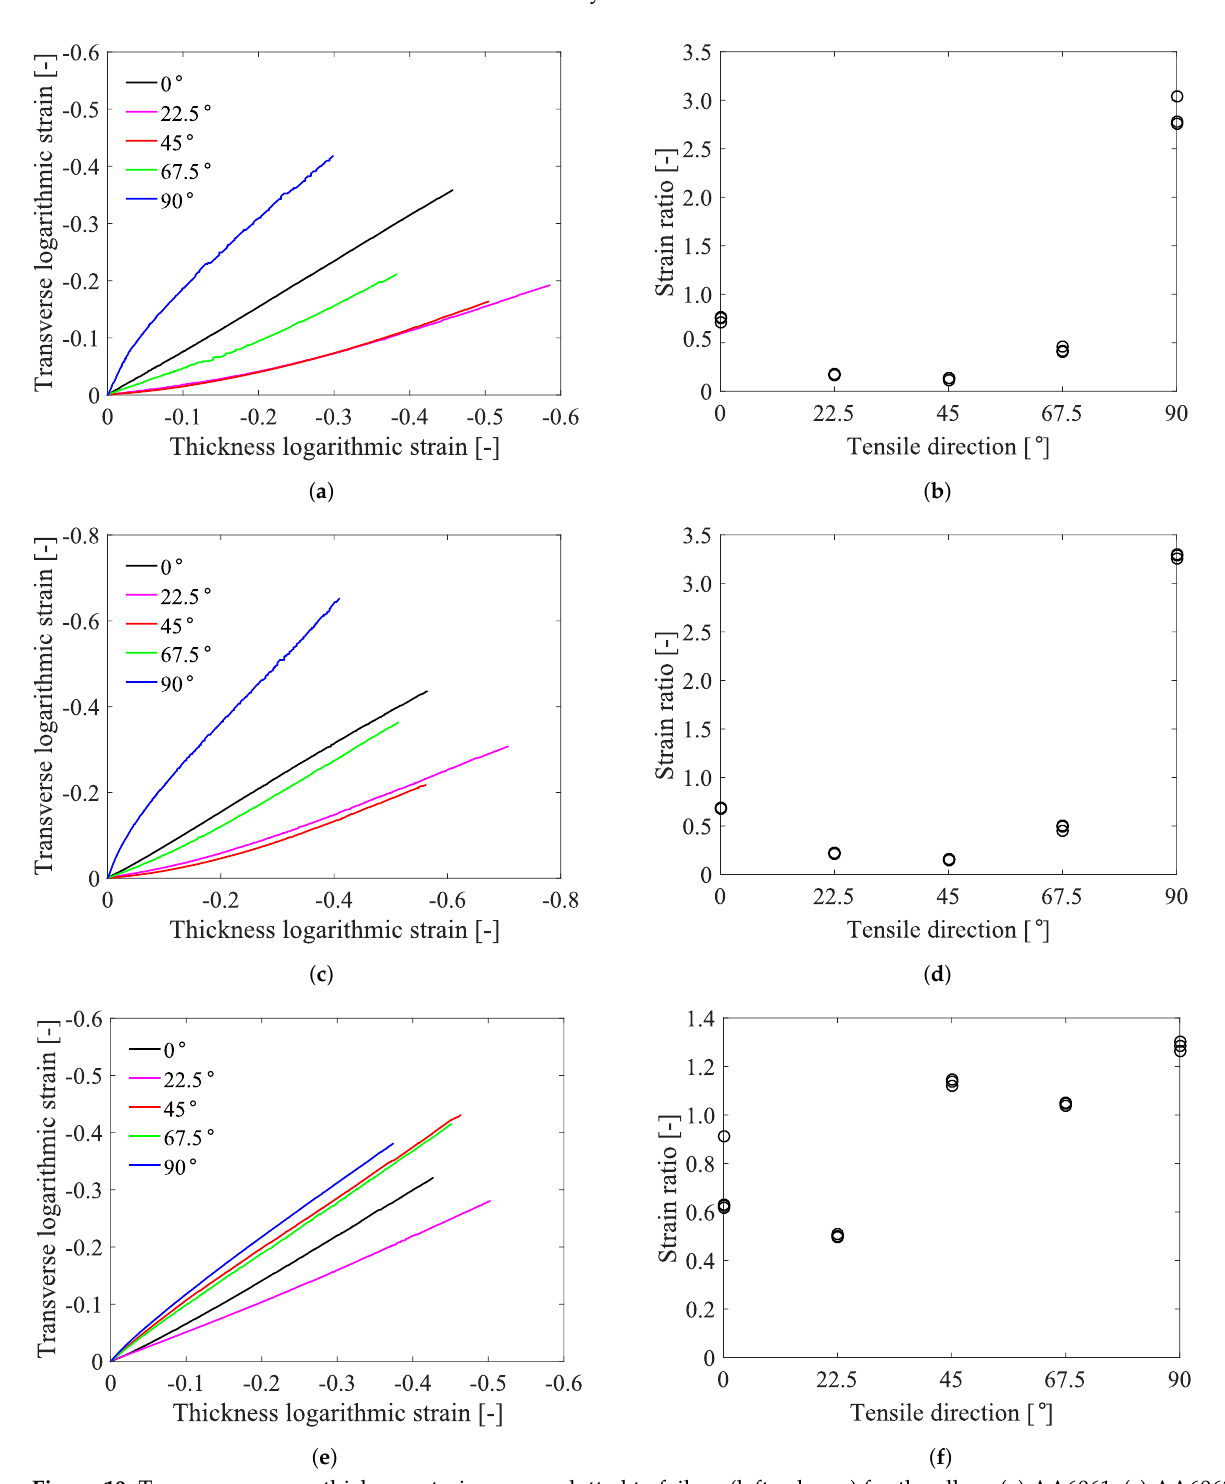
Figure 10. Transverse versus thickness strain curves plotted to failure (left column) for the alloys ( a ) AA6061, ( c ) AA6063 and ( e ) AA6110, and average strain ratio ( R -value) up to necking versus tensile direction (right column) for the alloys ( b ) AA6061, ( d ) AA6063 and ( f ) AA6110, all taken from the tensile tests on the smooth specimen for the three